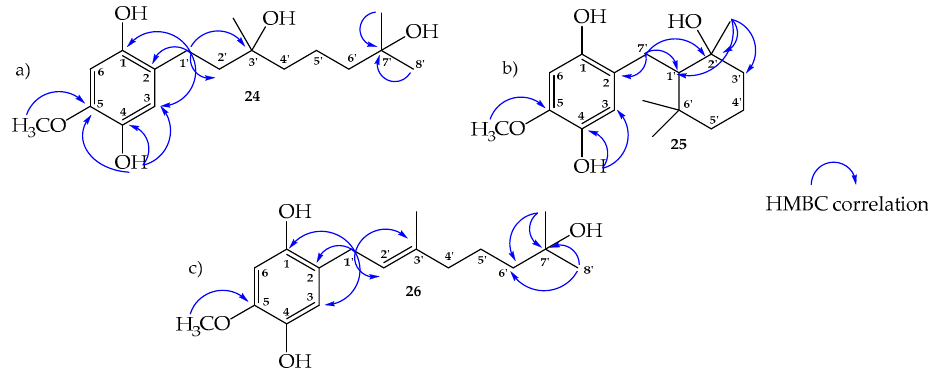
Figure 7. Major 2D HMBC observed correlations for Compounds 24 ( a ), 25 ( b ) and 26 ( c ).